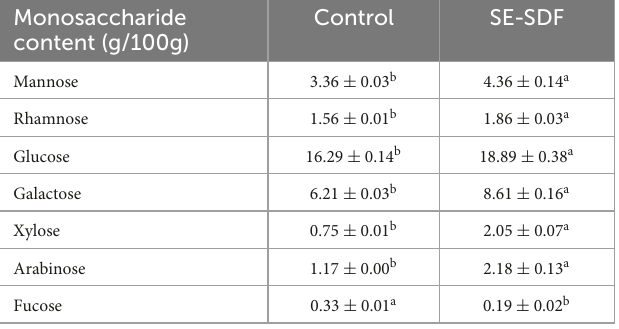
Data represent the mean and standard deviation of each sample assayed in triplicate. Different lowercaselettersinthesamecolumnindicatesignificantdifferences( p < 0.05).(SE-SDF:treated